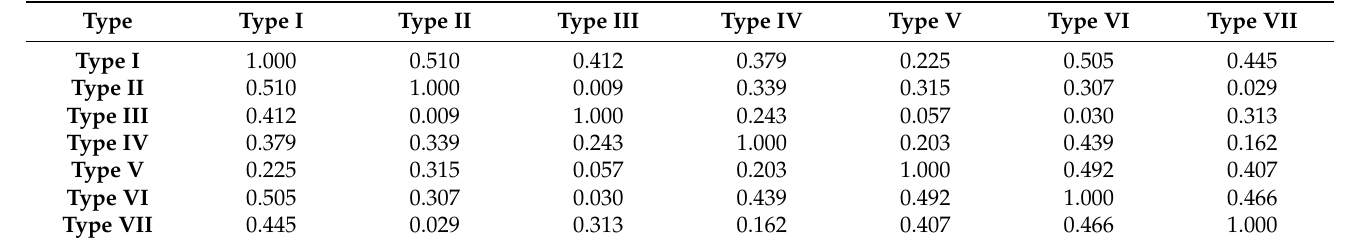
Table 3. Correlations between